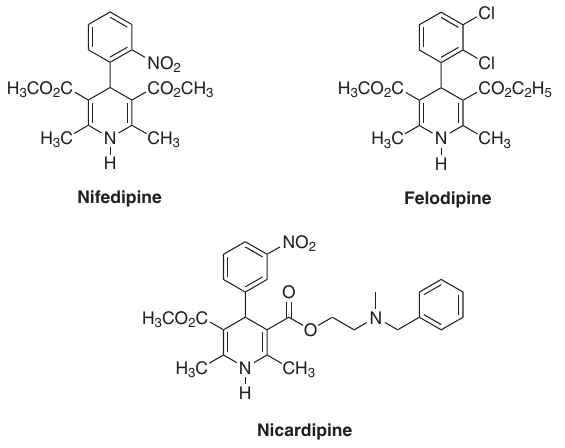
Figure 1 Selective examples of 1,4-dihydropyridine derivatives.